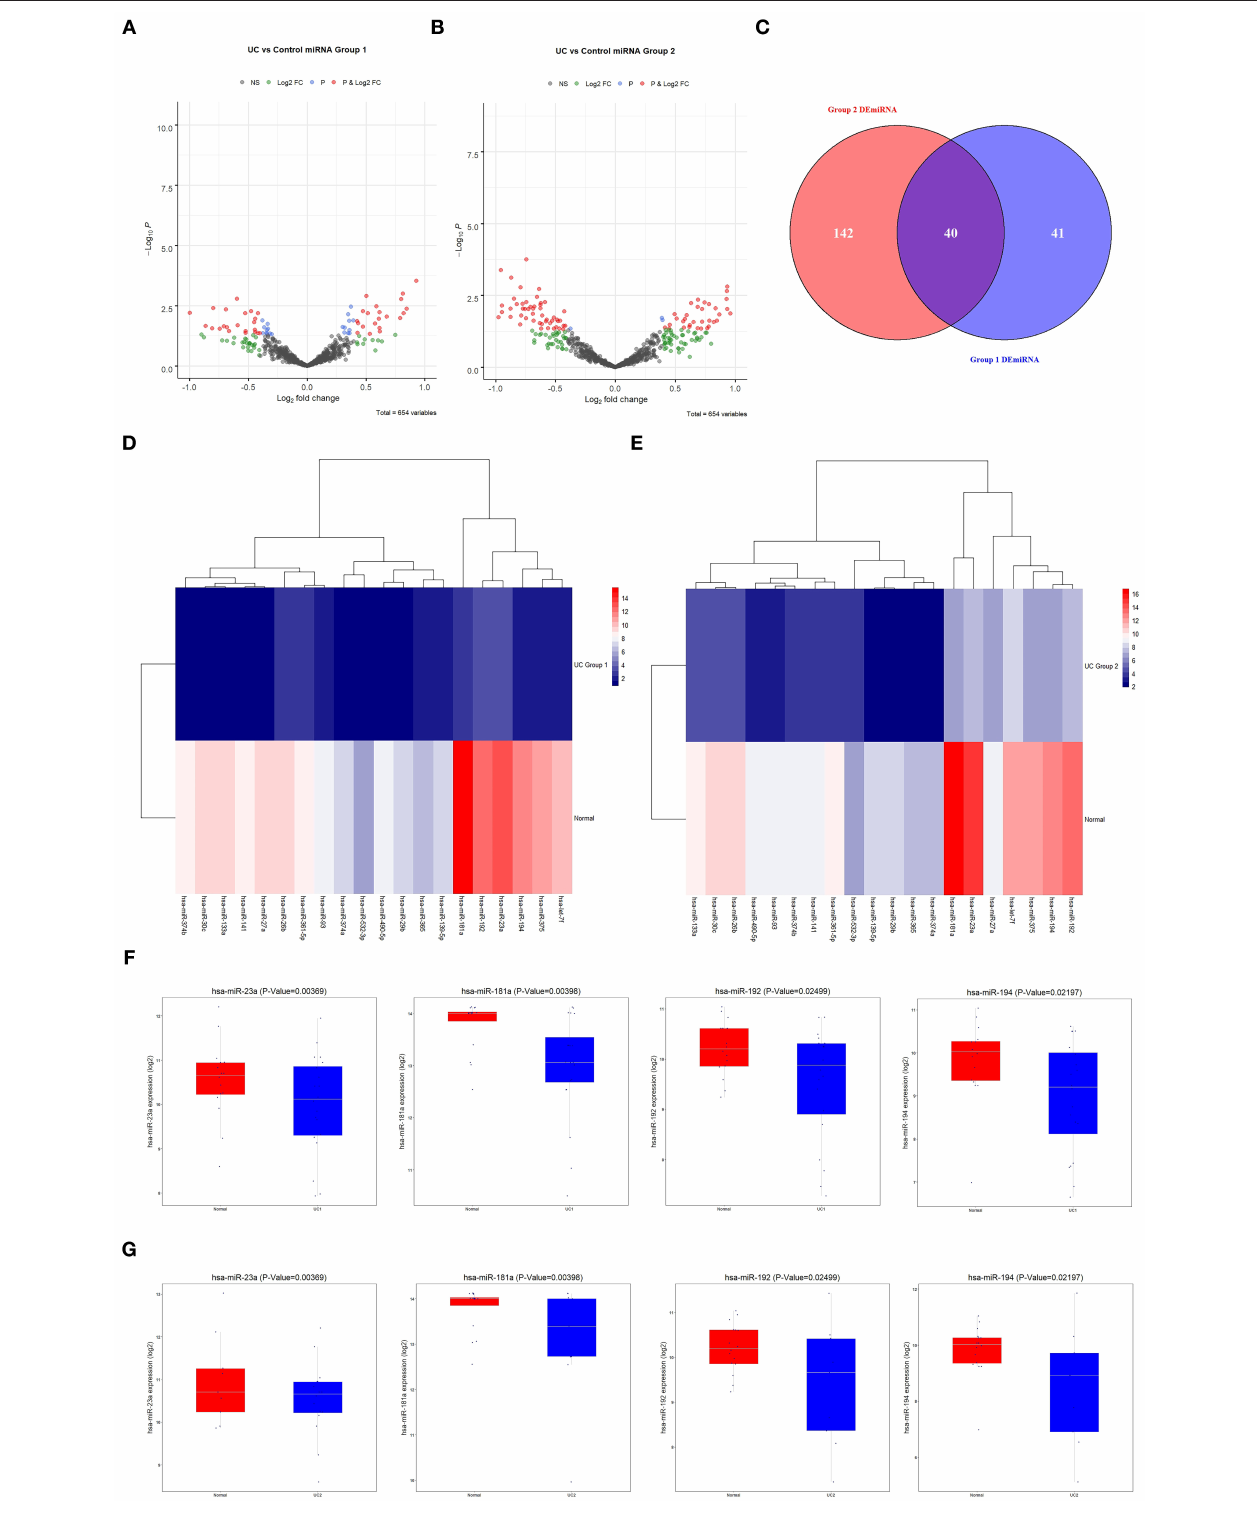
FIGURE 3 | Screening of differentially expressed miRNAs associated with UC. (A) The GEO database was used to analyze the expression of differentially expressed miRNAs in Group 1. (B) The GEO database was used to analyze the expression of differentially expressed miRNAs in Group 2. (C) Venn diagram of 40 candidate miRNAs. (D,E) Heat maps of 20 candidate miRNAs. (F,G) The expression levels of miR-23a, miR-181a, miR-192, and miR-194 in UC in Group 1 and 2 were analyzed using the GEO database. All were statistically significant. UC, ulcerative colitis; GEO, Gene Expression Omnibus.